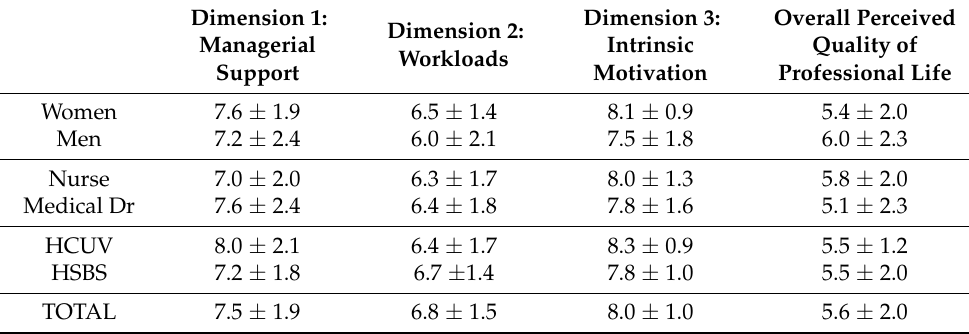
Table 4. Values obtained in the QPL-35